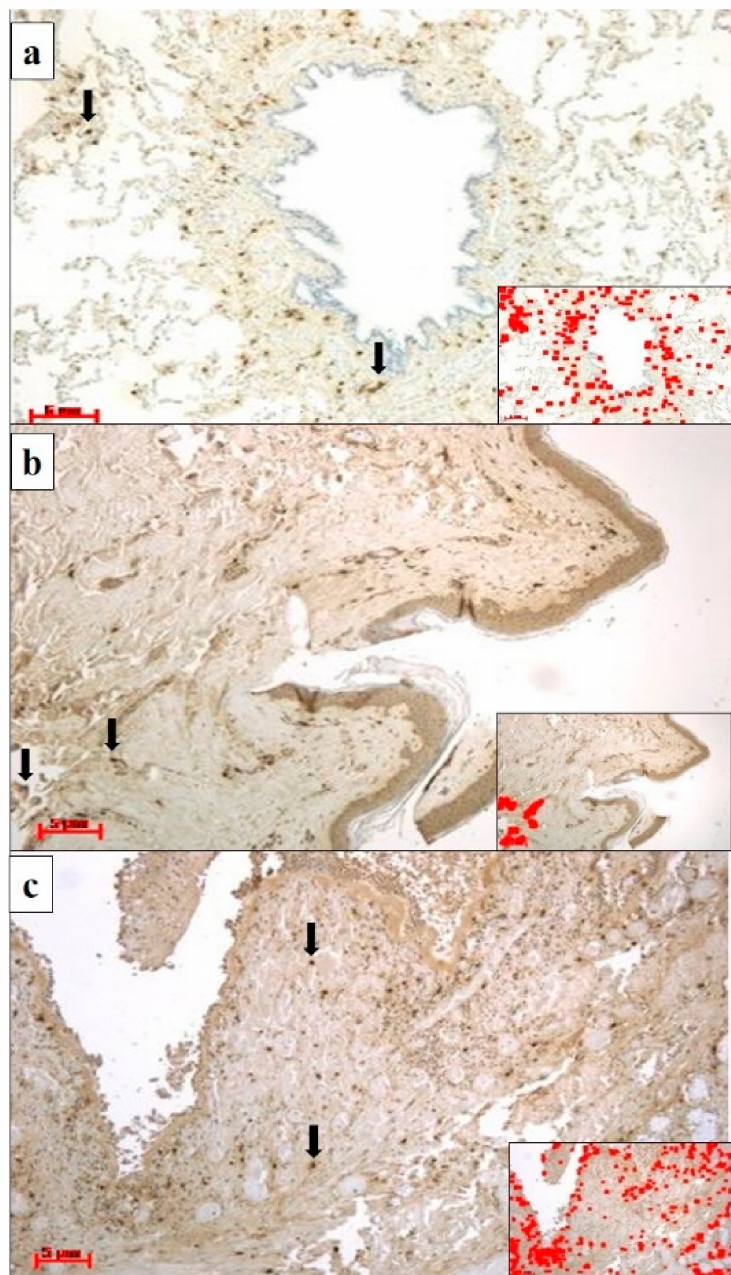
Figure 1. ( a ) Lung specimens from a cadaver who had died of anaphylactic shock; anti-tryptase antibody staining is strongly expressed in mast cells (black arrows) in the peribronchial interstitium. The insert shows the immunostaining software image analysis of Figure 1a, in which a highly immunostained area (red color) was detected (magnification: 20 × ; scale bar: 5 µ m). ( b ) Skin specimens of the gluteus where medication administration occurred from a cadaver who had died of anaphylactic shock; anti-tryptase immunolocalization (black arrows) was demonstrated in the derma of the medication injection site. The insert shows the immunostaining software image analysis of Figure 1b, in which a highly immunostained area (red color) was detected (magnification: 20 × ; scale bar: 5 µ m). ( c ) Glottis specimens of a cadaver who had died of anaphylactic shock showed strong anti-tryptase immunoexpression in mast cells (black arrows). The insert shows the immunostaining software image analysis of Figure 1c, in which a highly immunostained area (red color) was detected (magnification: 20 × ; scale bar: 5 µ